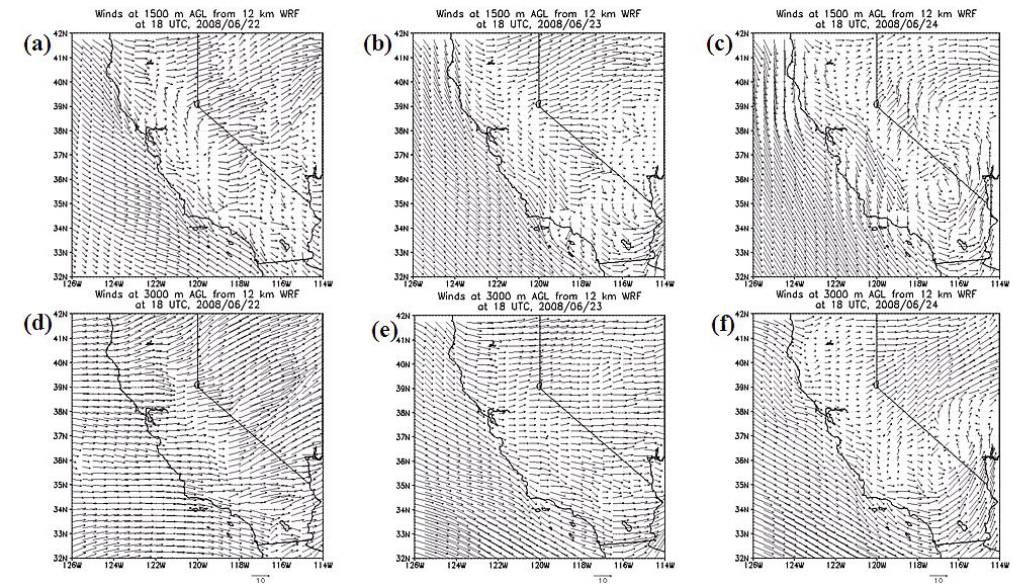
Fig. 3. 12km wind fields at roughly 1500m (a–c) and 3000m (d–f) above ground level (a.g.l.) over California at 18:00UTC on 22 June (a; d), 23 (b; e) and 24 (c;